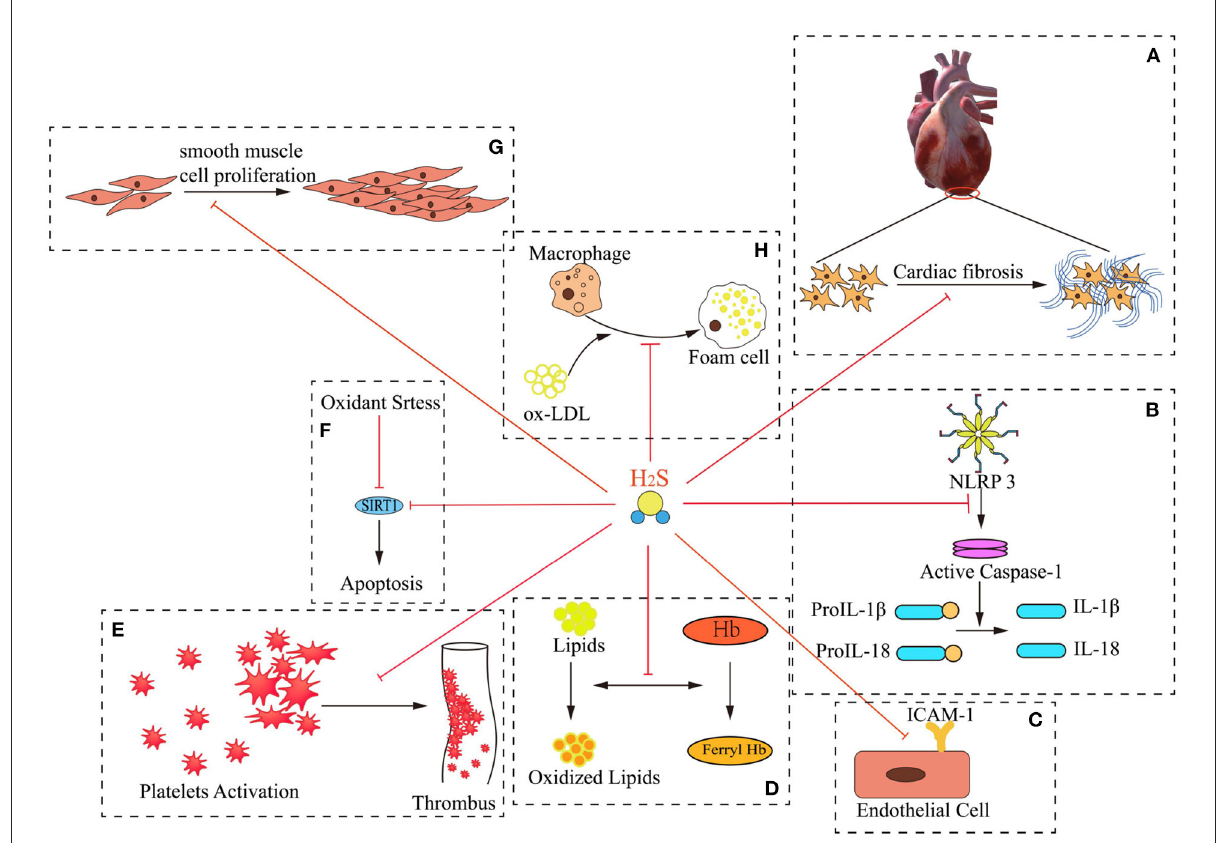
FIGURE1 Mechanisms of H 2 S “multi-angle” inhibition of AS. H 2 S exerts numerous critical effects against the pathogenesis of atherogenesis. These include: (A) improving myocardial fibrosis; (B) inhibiting the production of IL-1 β and IL-18; (C) inhibiting ICAM-1 expression in TNF-alpha-induced HUVECs via the NF-kappa B pathway; (D) preventing lipid peroxidation; (E) inhibiting intravascular thrombosis; (F) protecting against apoptosis under oxidative stress through SIRT1 pathway; (G) inhibiting smooth muscle cell proliferation; (H) attenuating foam cell